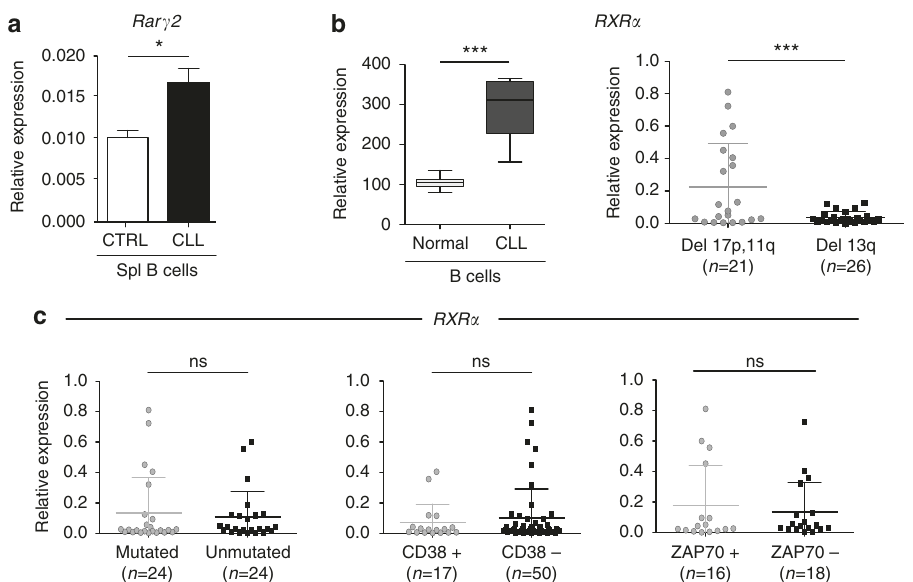
Fig. 6 Increased expression of RA-nuclear receptors in human primary CLL cells correlates with bad prognosis. a qPCR analysis of Rar γ 2 expression in E μ -TCL1 CLL and control B cells. Data are representative of one out of fi ve mice analyzed. The mean of triplicates and ±SD are shown. * p < 0.05. b Relative RXR α expression data of puri fi ed B-cells from healthy donors and CLL patients ( b , left) from public repository, and expression of RXR α in CLL patients with different genomic aberrations ( b , right). *** p < 0.001. c Correlation analysis of RXR α expression from puri fi ed CLL cells from patients with different IGHV mutational status, CD38 and ZAP70